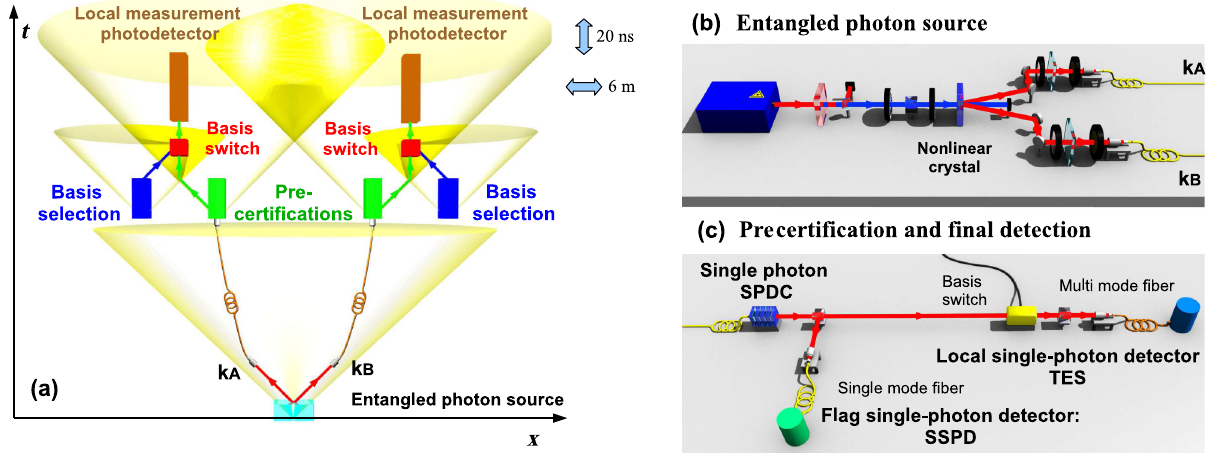
FIG. 1. (a) Space-time diagram of a Bell test based on local precertification of the photon’s presence. Green box: Precertification stage. Blue box: Basis selection. Red box: Measurement process. Orange box: Final measurement stage. (b) Source of polarization- entangled states. (c) Precertification and detection